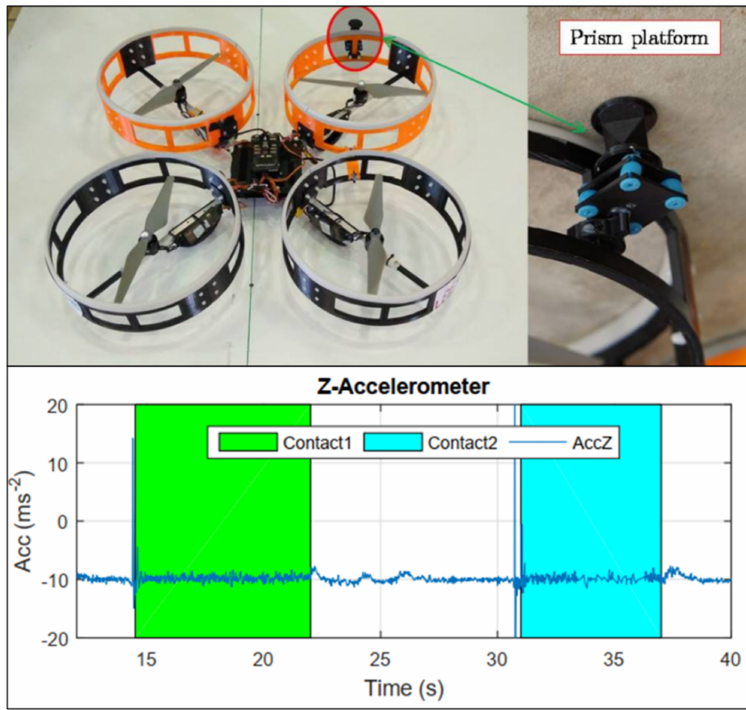
Figure 8. Contact based data acquisition using sensor-embedded UAV